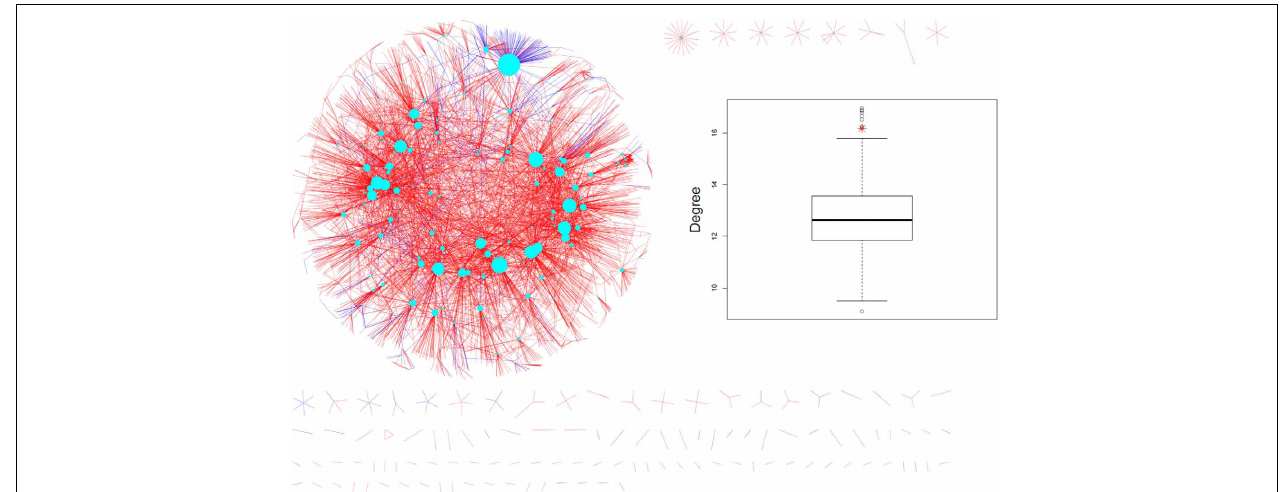
FIGURE 2 | Measured phosphoproteins mapped onto the AtPIN (june_2010 version). The cyan nodes represent the phosphorylated proteins detected in the experiments and the size of the node is proportional to its degree. Coloring of the edges reflect the nature of the evidence such as experimental (blue color) or predicted (red color).